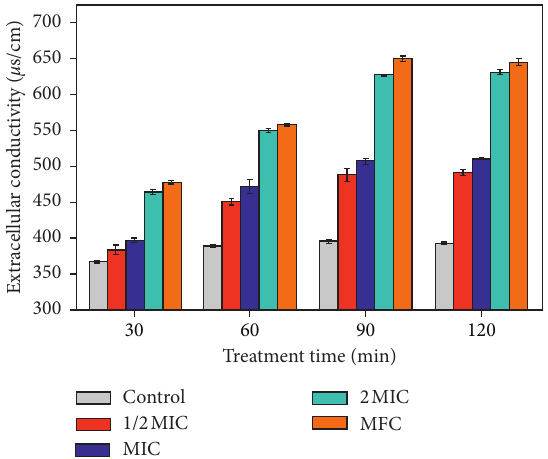
Figure 4: Effect of 4-methoxy CA on extracellular conductivity of P. digitatum suspensions. Values are mean ± SE ( n � 3).